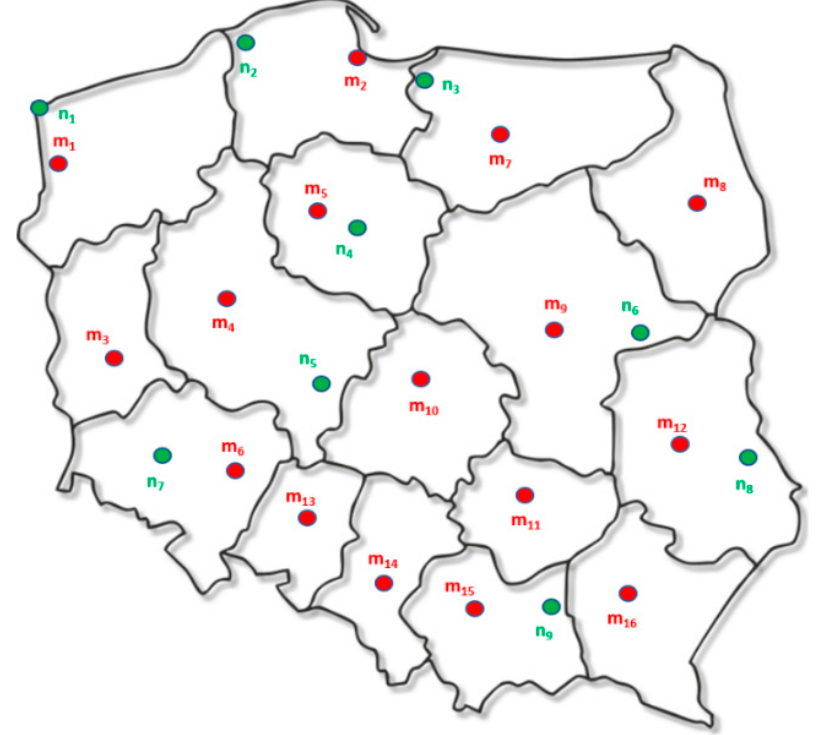
Figure 2. Locations of suppliers and recipients.